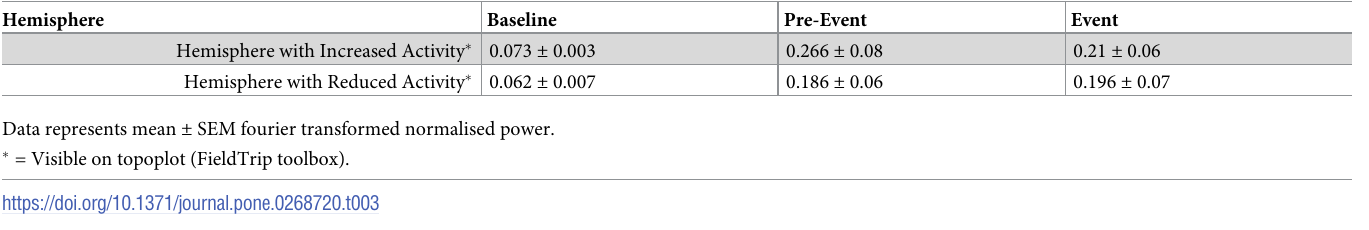
Table 3. Mean ± SEM z-Scored hemispheric power at baseline and throughout event. Hemisphere Baseline Pre-Event Event Hemisphere with Increased Activity � 0.073 ± 0.003